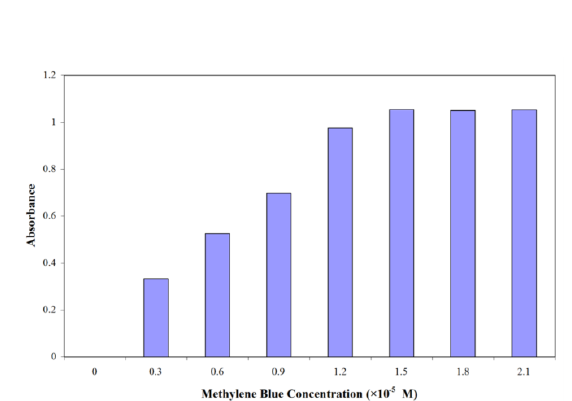
Figure 2. Effect of the volume of chloroform (microextraction solvent) on the absorbance of AS-MB ion-pairs obtained from DLLME. Extraction conditions, as with Fig. 1; concentration of MB, 5.0×10 -5 mol L -1